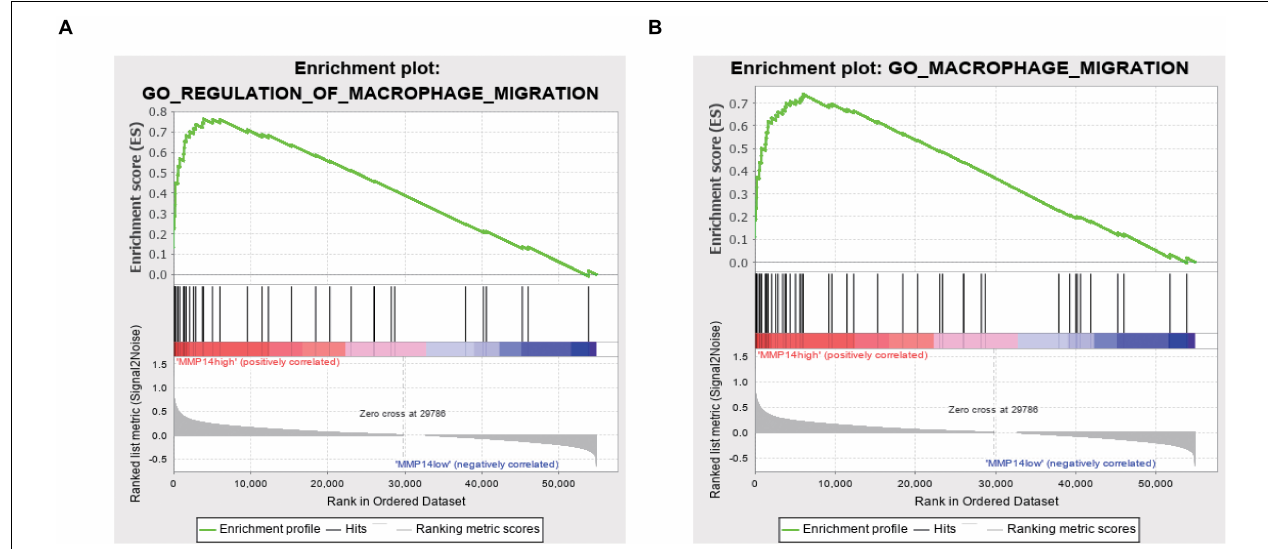
FIGURE 3 | (A) GO Enrichment plot of the regulation of macrophage migration profile of the analyzed gene set. The enrichment score (ES) is shown and genes are ordered according to the rank-ordered list. (B) GO enrichment plot of the macrophage migration profile of the analyzed gene set. The enrichment score (ES) is shown, and genes are ordered according to the rank-ordered list.